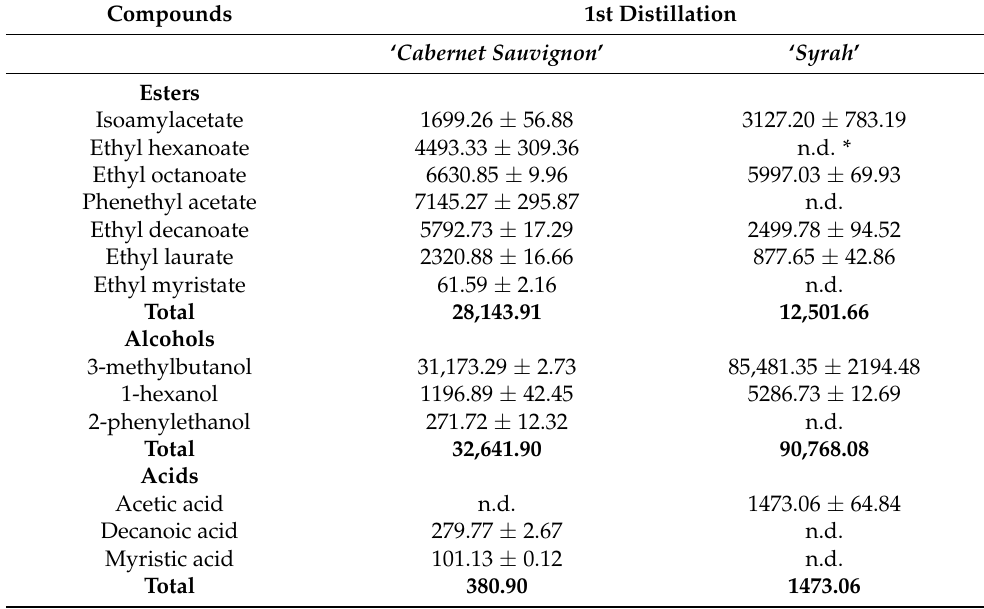
Table 6. Volatile compounds ( µ g/L) identified in ‘ Cabernet Sauvignon ’ and ‘ Syrah ’ wine spirit. Compounds 1st Distillation ‘ Cabernet Sauvignon